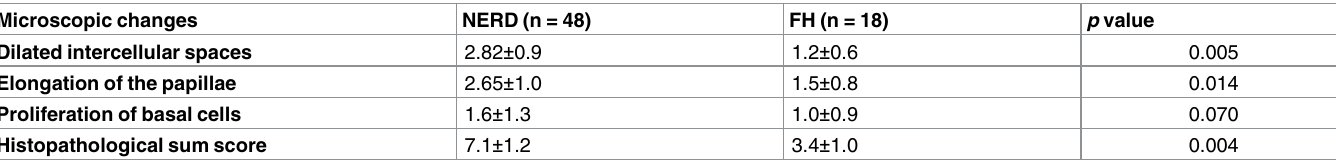
Table 3. Histopathological characteristics of patients with non-erosive reflux disease (NERD) and functional heartburn (FH) in relationship to diagnosis. Microscopic changes NERD (n = 48) FH (n = 18) p value Dilated intercellular spaces 2.82 ± 0.9 Elongation of the papillae Proliferation of basal cells Histopathological sum